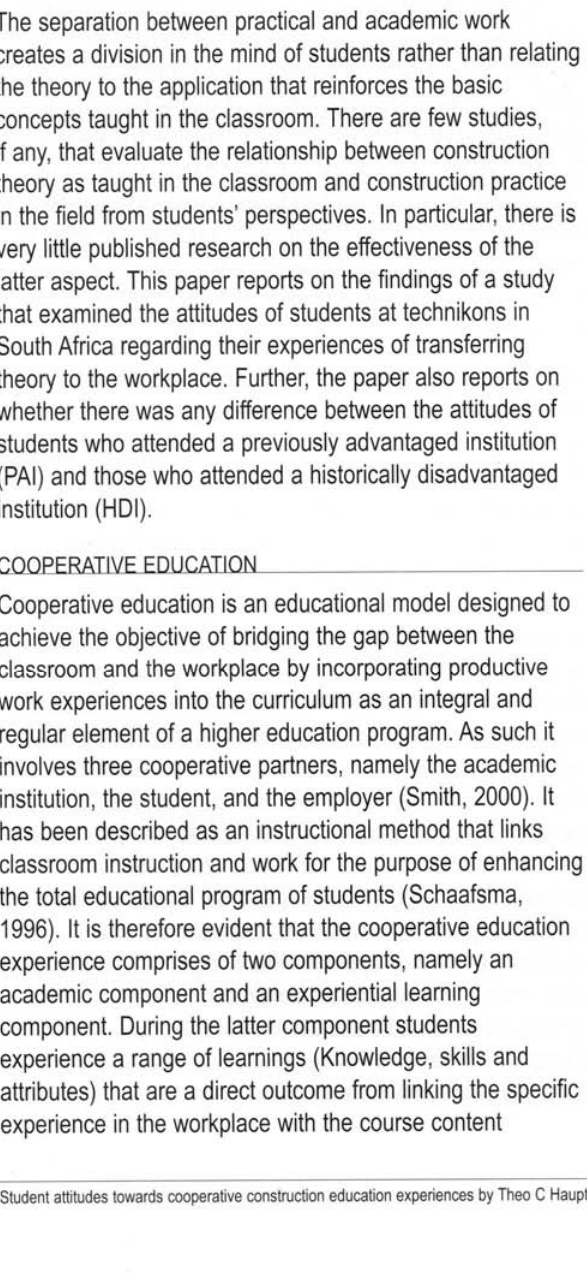
Table 1. Traditional education vs Workplace (Source: Cook and Cook,